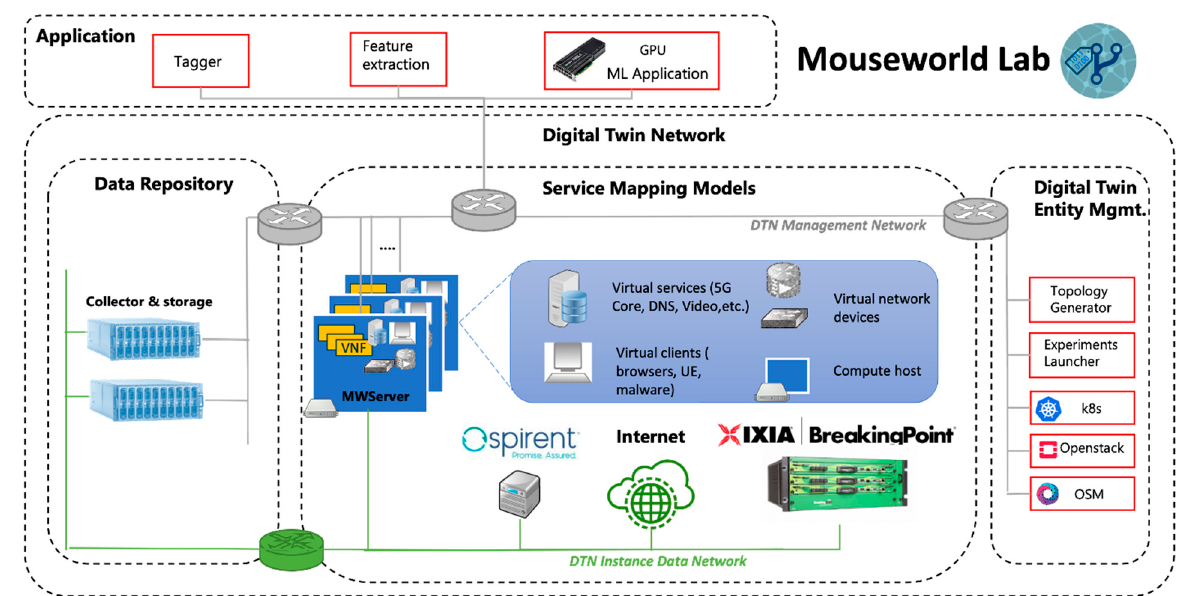
Figure 1. Mouseworld